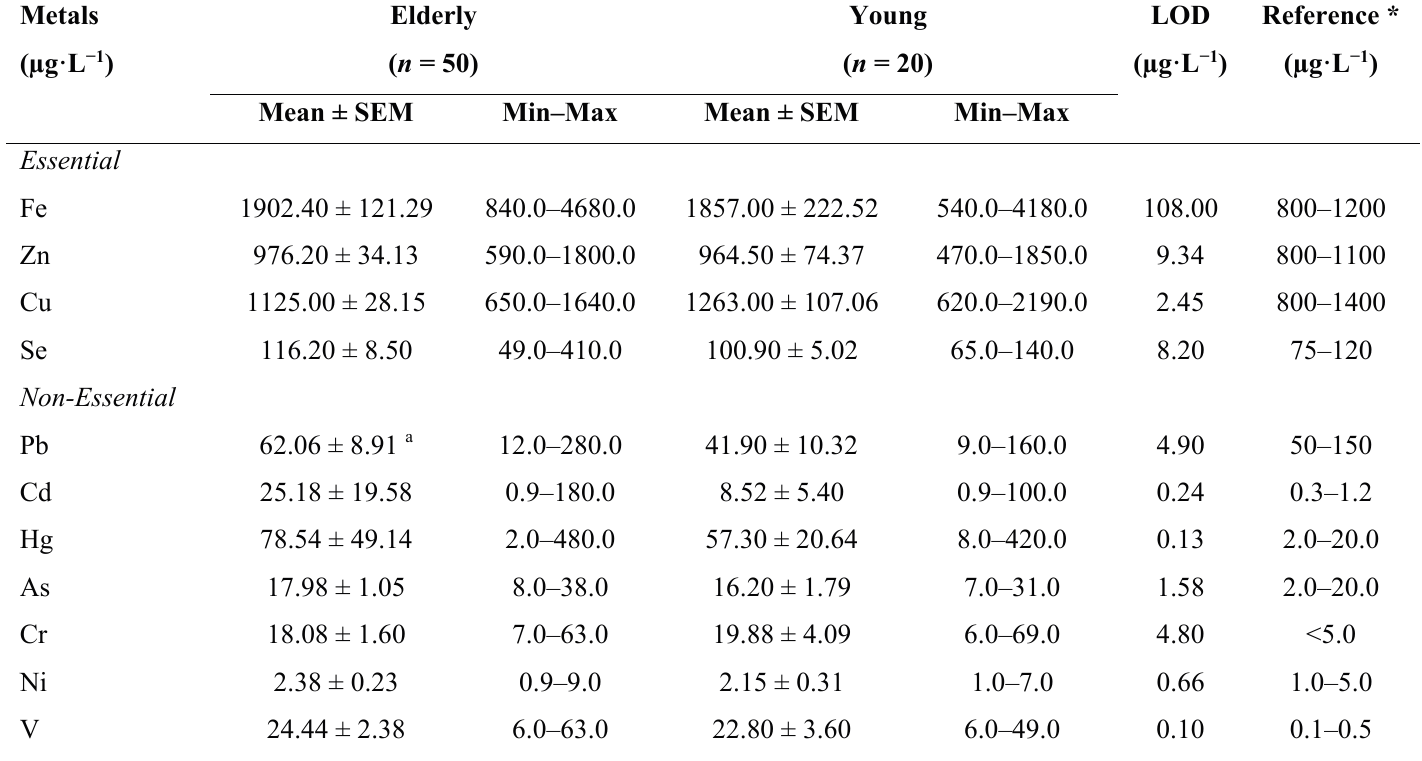
Table 4. Metal levels in serum and whole blood of the studied